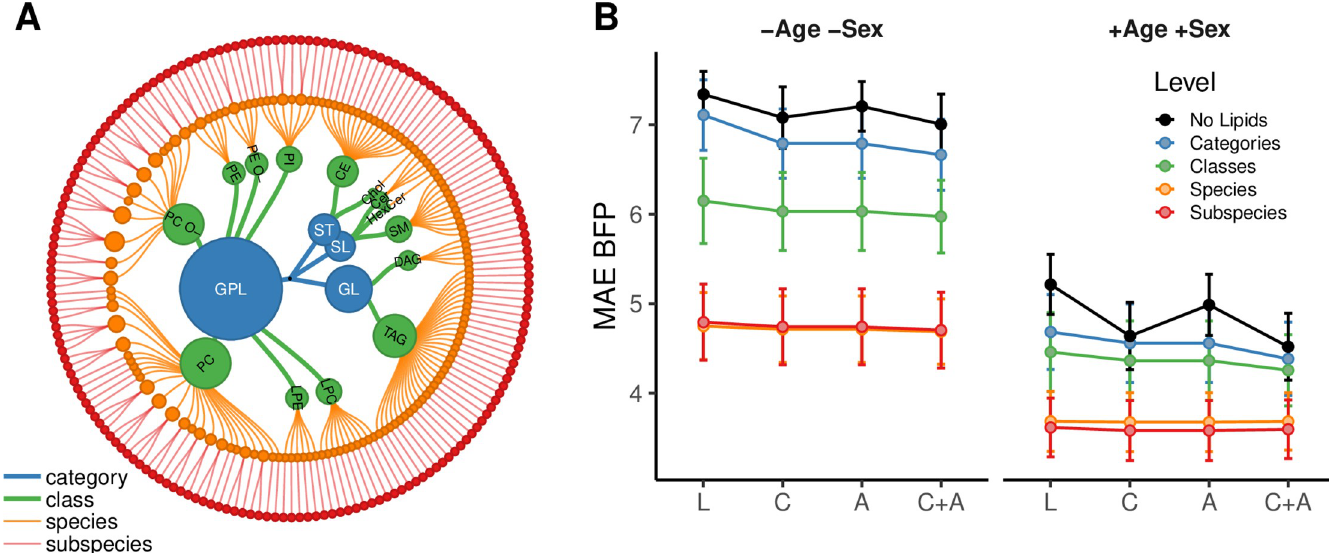
Fig 3. Effect of different input variables and lipidome detail on the BFP regression. (A) Lipidome hierarchy. The FINRISK lipidome, used for modeling, can be aggregated into 4 categories, 14 lipid classes, 143 species, and 183 lipid species and subspecies (S6 Fig). (B) MAE cross-validation mean and standard deviation ( n = 50) based on lipidomes of the FINRISK training data set ( n = 796) are shown on the y-axis. Modeling was either done without age and sex as covariables ( − Age − Sex) or with (+Age +Sex). Results are colored according to lipidome detail. Either no lipid information was used (No Lipids), or lipidome information was aggregated into lipid categories (Categories), lipid classes (Classes), and lipid species (Species). Subspecies denotes the highest structural resolution possible on the platform with a mix of species and subspecies. Variables in addition to the lipidome are shown on the x-axis: No additional input [L]; routine clinical laboratory variables [C]: total cholesterol, HDL cholesterol, LDL cholesterol, triglycerides, HDL to LDL ratio, total cholesterol to HDL ratio, triglycerides to HDL ratio; additional variables [A]: blood pressure treatment, lipid treatment, smoker, pregnant, fasting, prevalent diabetes, prevalent CVD, prevalent liver disease, prevalent coronary heart disease, prevalent stroke, systolic blood pressure, diastolic blood pressure; or the combination of clinical and additional variables [C + A]. Special points are the zero model (L, No Lipids, − Age − Sex), which does not use any predictors but returns the mean of the BFP variable, and the regression only based on age and sex, (L, No Lipids, +Age +Sex), both of which are used as references for BFP predictability without regression based on L, C, or A input (S8 Table). BFP, body fat percentage; CVD, Cardiovascular disease; HDL, high-density lipoprotein; LDL, low-density lipoprotein; MAE, mean absolute error.